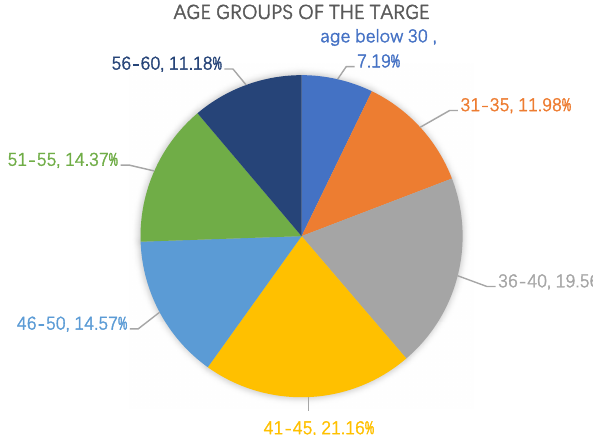
Figure 2. Age group of the target